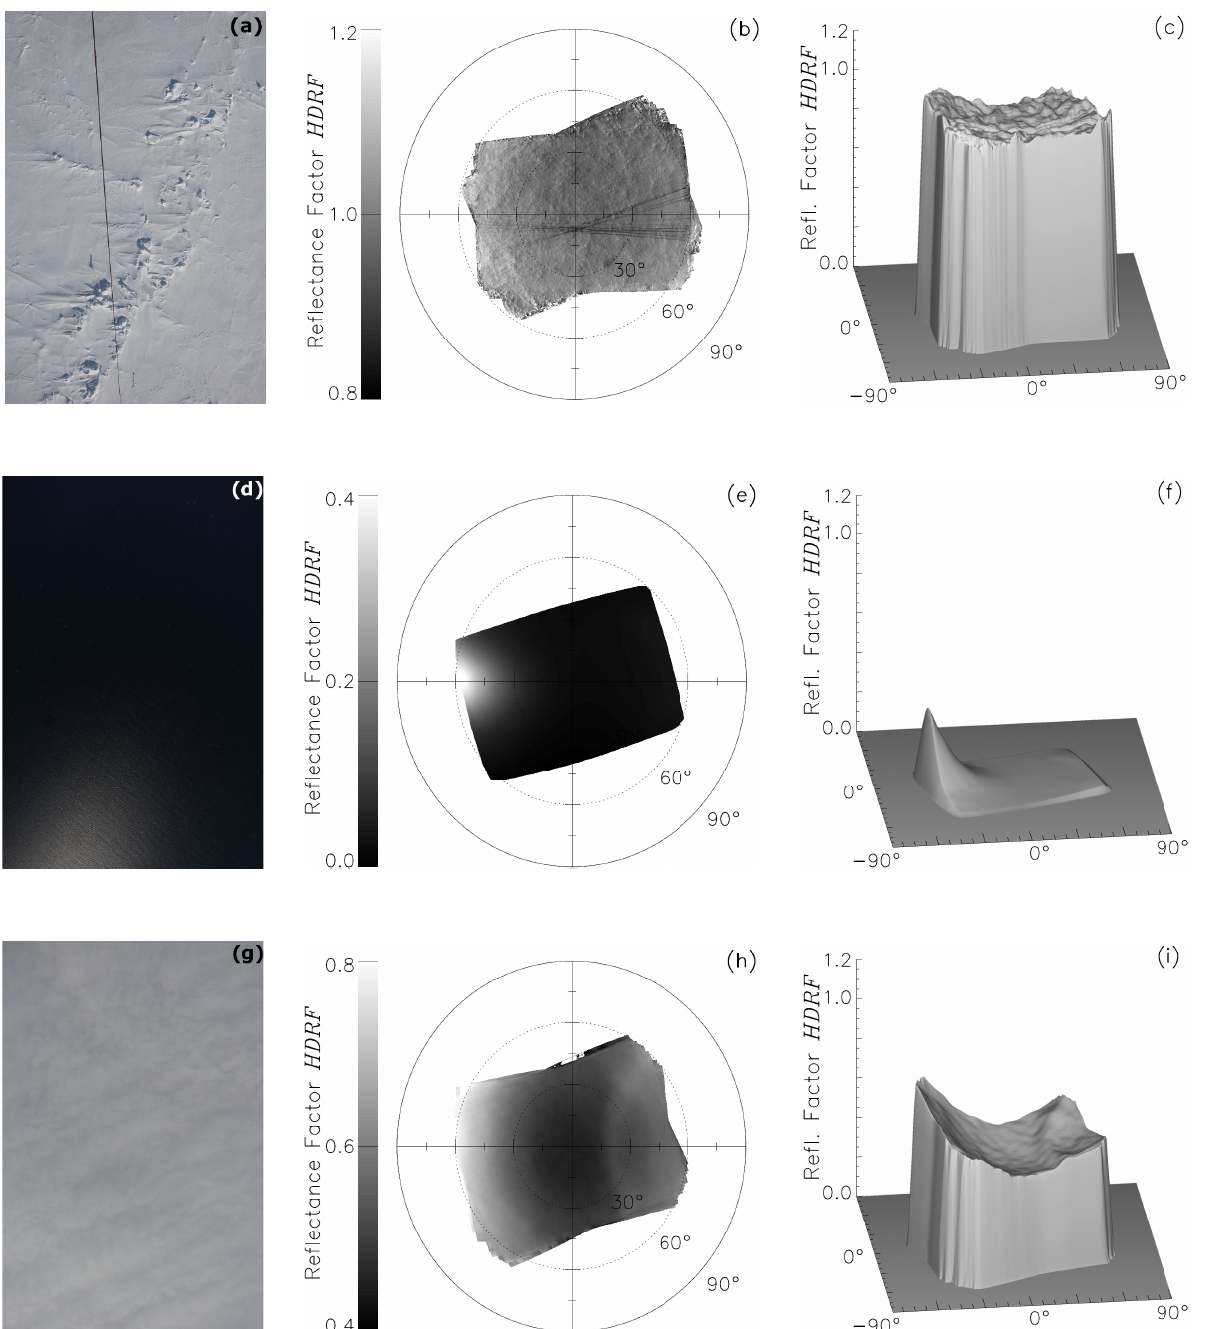
Fig. 6. HDRF measurements with the CANON camera (channel 2) above sea ice (top, θ 0 = 67 . 0 ◦ ), open water (center, θ 0 = 61 . 1 ◦ ), and clouds (bottom, θ 0 = 56 . 5 ◦ ). The left column (a, d, g) shows exemplary individual camera images. The averaged HDRF is shown in the center column as polar plot (b, e, h) and as smoothed surface in the right column (c, e, i) .